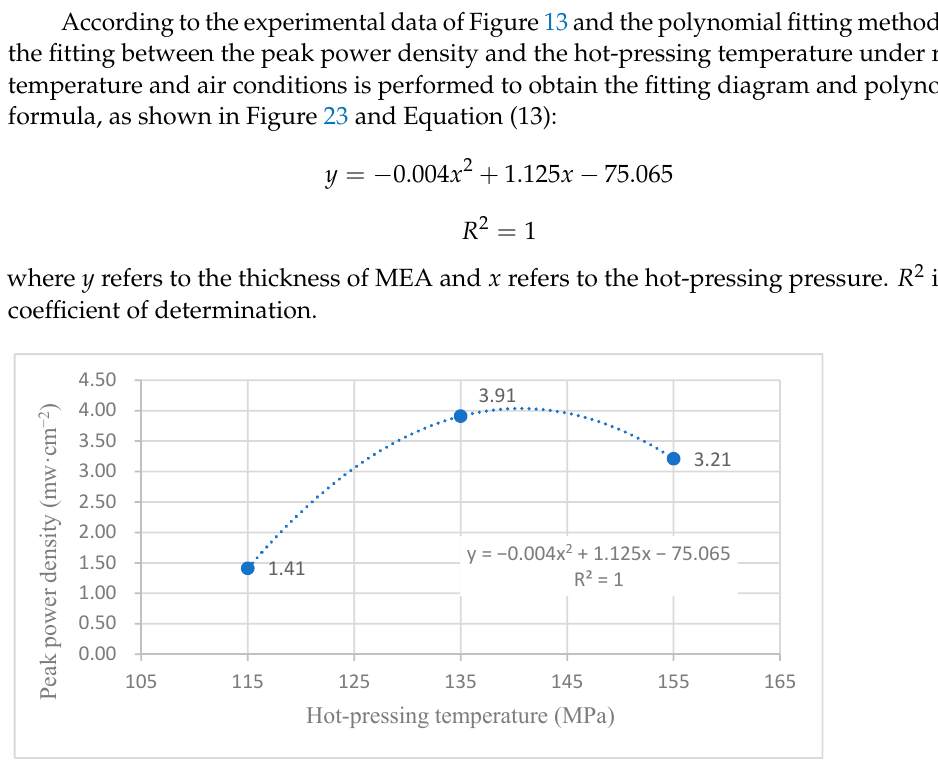
Figure 23. The fitting curve of the peak power density of MEA at a different hot-pressing temperature under room temperature and air conditions.